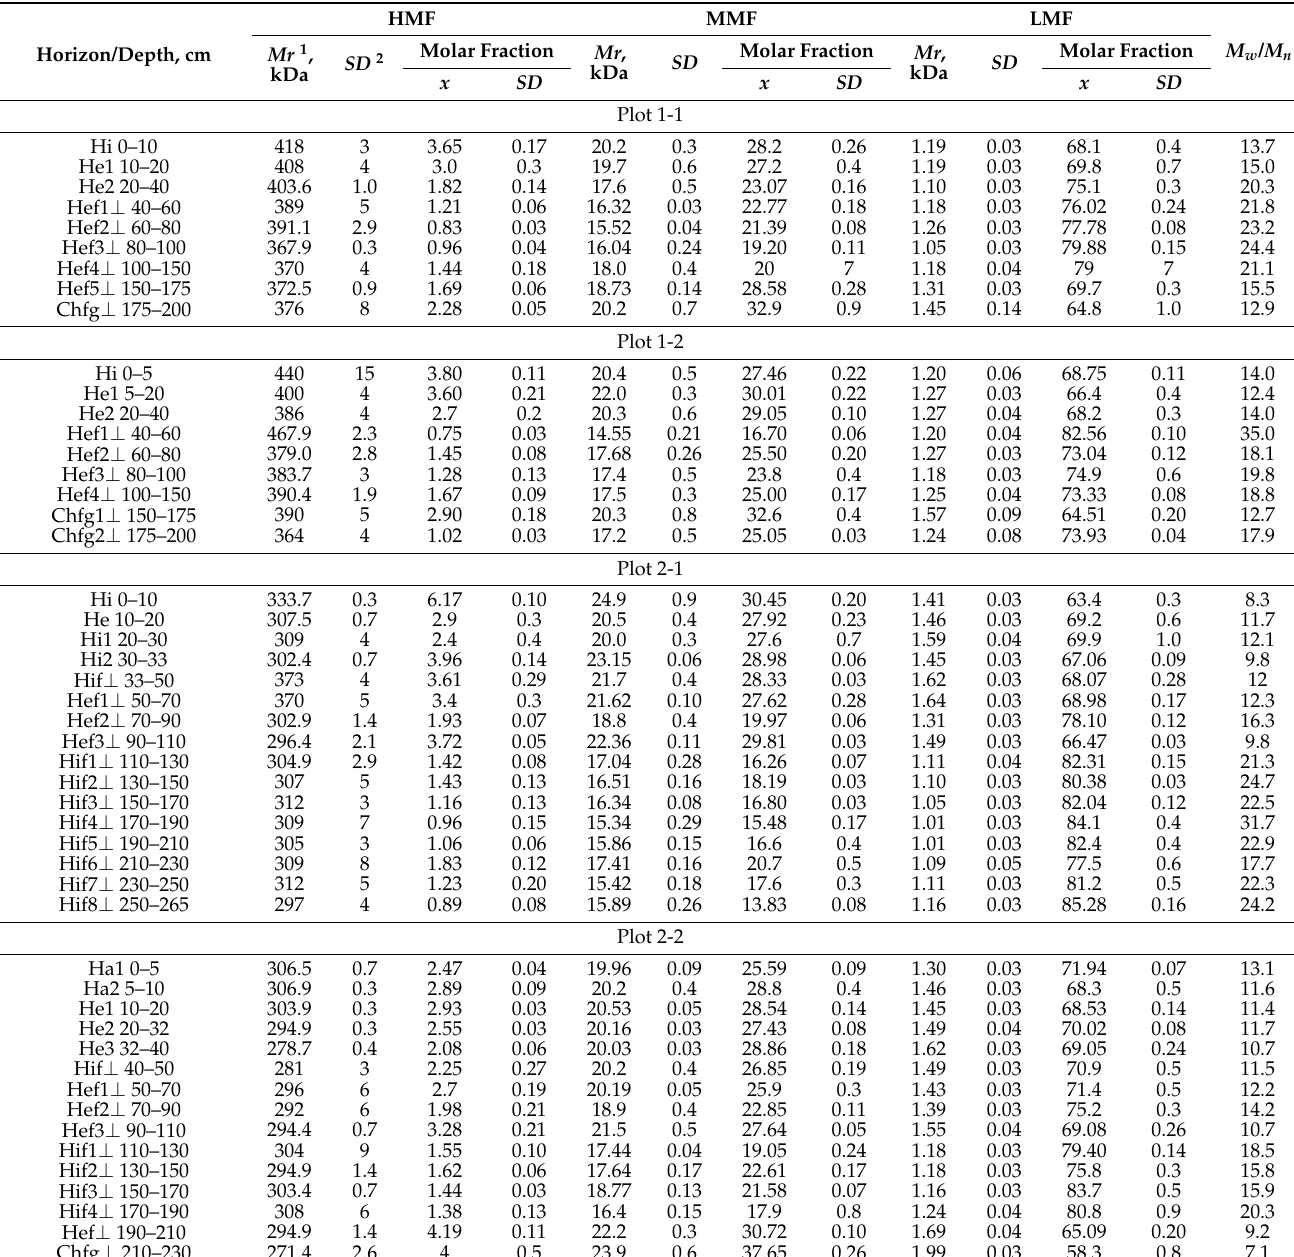
Table 2. Apparent molecular weight distribution of the